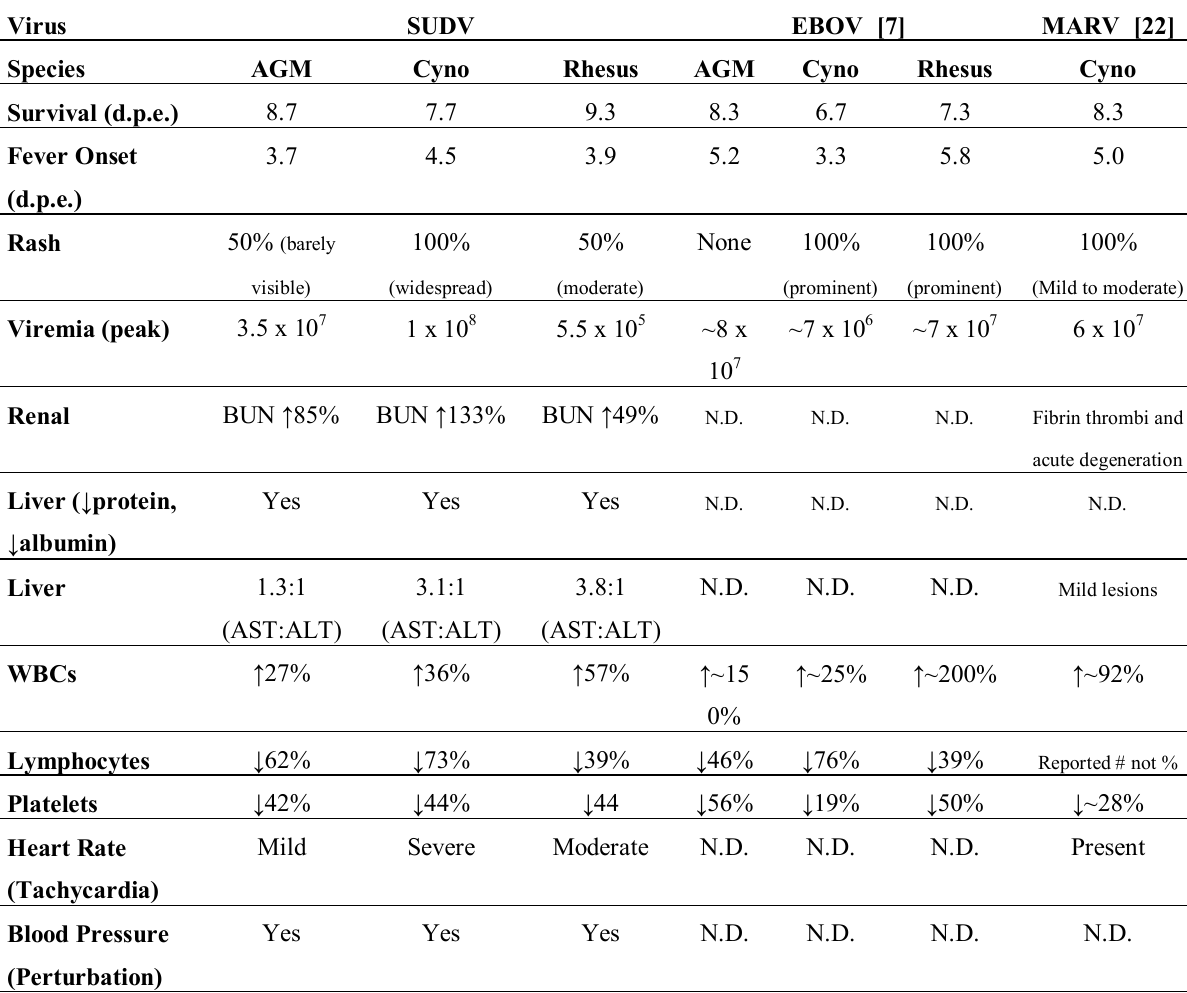
Table 3. Comparison of aerosol exposure of NHPs to